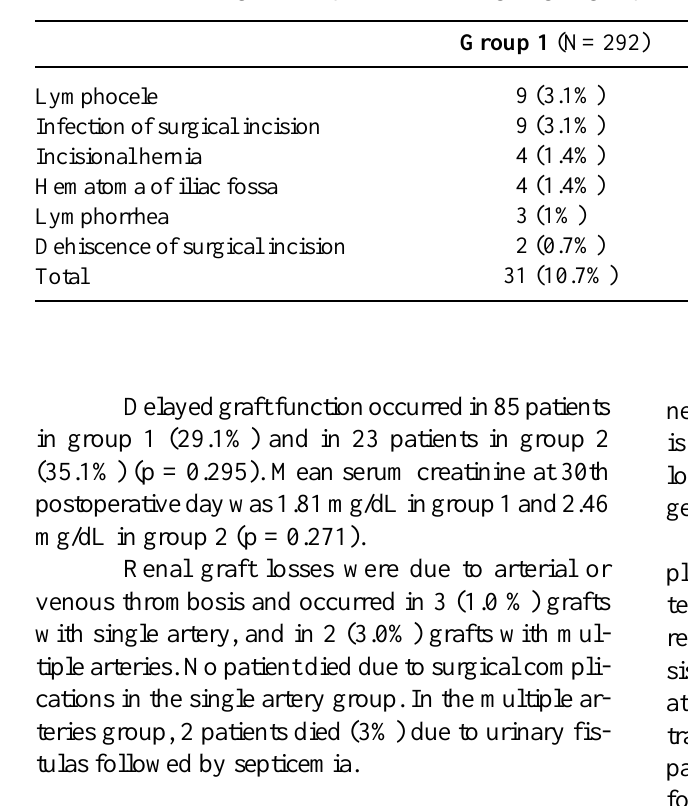
Table 6 – Other surgical complications among single (group 1) and multiple (group 2) arteries grafts